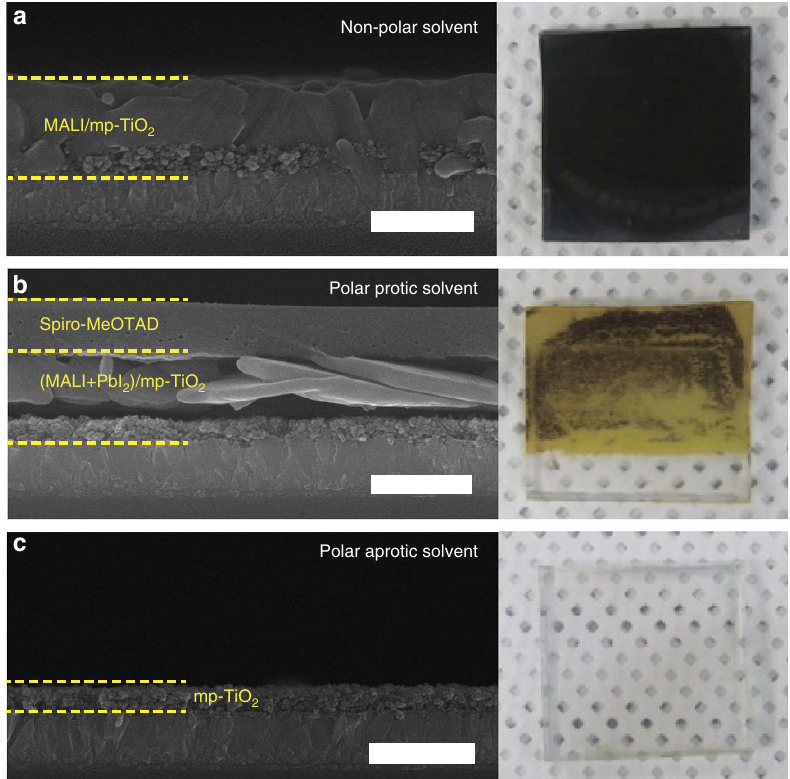
Figure 3 | Features of PCSs dissolved in three different types of solvents. Cross-sectional FESEM and photographic images of dissolved PCSs obtained after 30s of immersion of spiro-MeOTAD/MALI/mp-TiO 2 /TCG in ( a ) non-polar, ( b ) polar protic and ( c ) polar aprotic solvents. Diethyl ether, water and DMF, respectively, were used as the representative solvents. Scale bars,